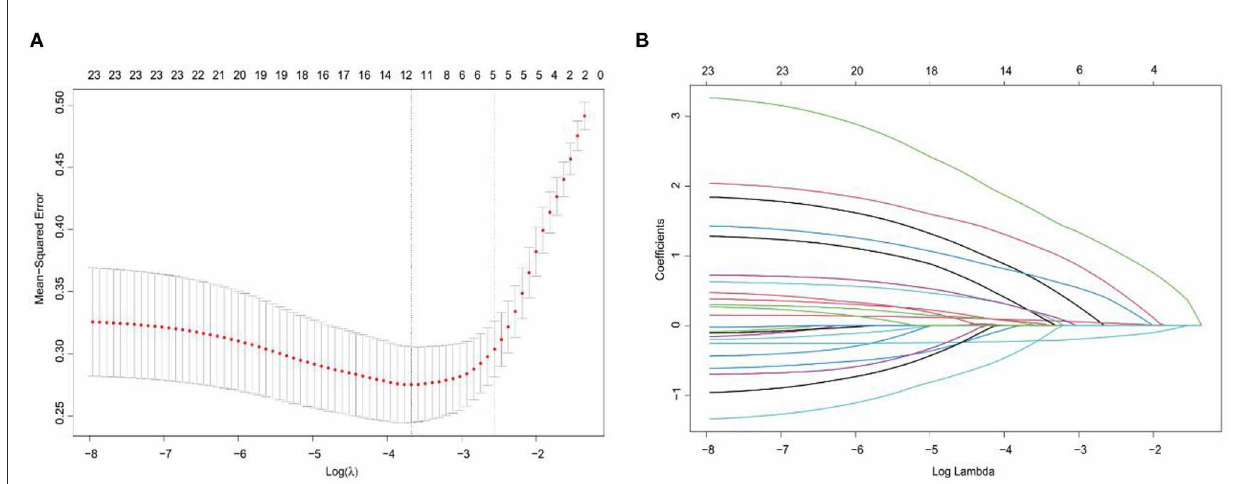
FIGURE1 Selection of potential predictors using a LASSO regression model. (A) The optimal parameter (lambda) in the LASSO model was confirmed in the model by tenfold cross-validation of the minimum criterion. A dashed vertical line is drawn at the optimal value by using the smallest criterion (left dashed line) and one standard error of the smallest criterion (lambda.1SE) (right dashed line). (B) The model is optimal when λ increases to a standard error (lambda.1SE), and variables with nonzero coefficients were screened out as potential predictors. It effectively decreased the 21 influencing factors to 5 as potential